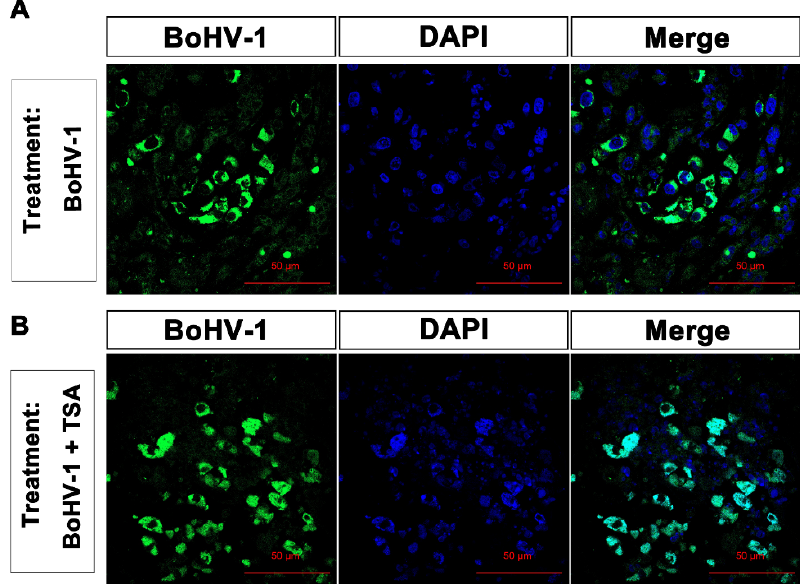
Figure 8. The detection of virion-associated proteins in the tumor sections with IFA. Tumor sections treated by BoHV-1 ( A ) and BoHV-1-TSA ( B ) were processed for the detection of virion-associated proteins with immunohistochemistry by using the anti-BoHV-1 serum. Images shown were represents of each group.